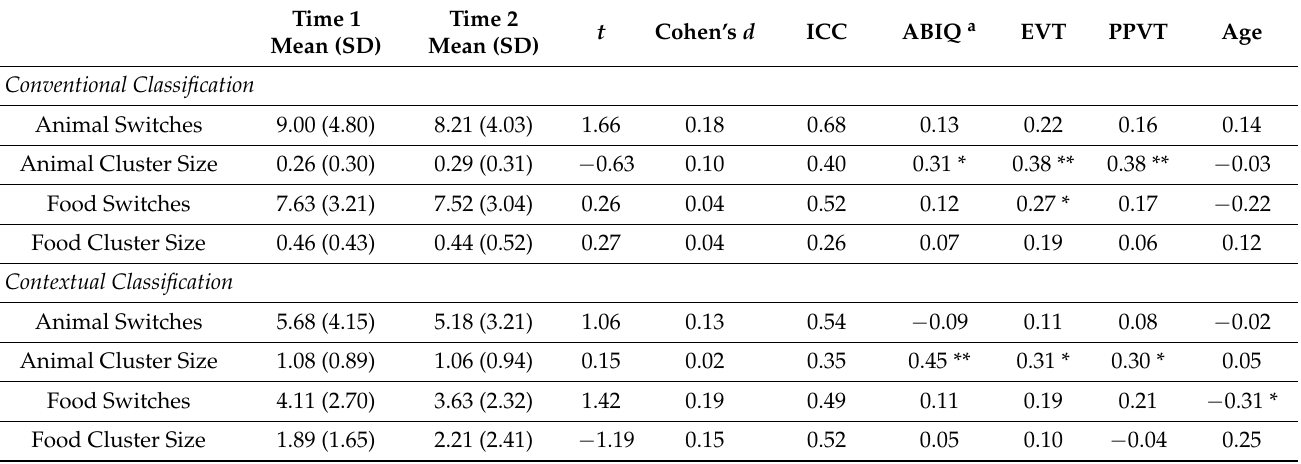
Table 3. Means, practice effects, test–retest reliability, and associations with broader developmental domains for verbal fluency tasks; animal subtest n = 56 and food subtest n =